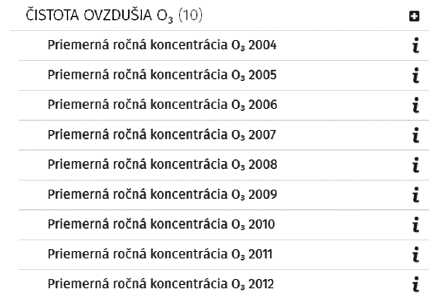
Fig. 2. Time series of S (M,Isogr) data as available AC in the layer tree of the presented web mapping application: one layer per one year